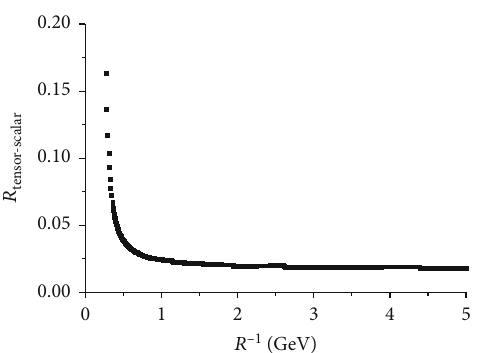
_ _ = 0 : 01 , R R = 0 Figure 5: The spectral index in the logamediate in fl ation scenario as a function of R − 1 for R = 0 : 1 , λ = 10 , A = 1 , and f = 1/2 .